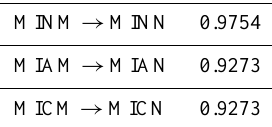
Figure 5. Modeled values of the lidar ratio for “desert” aerosol un- der the assumption of spherical and non-spherical particles. Table 3. Reduction factors for particle volume and mass for the non- spherical mineral components, compared to the old components.